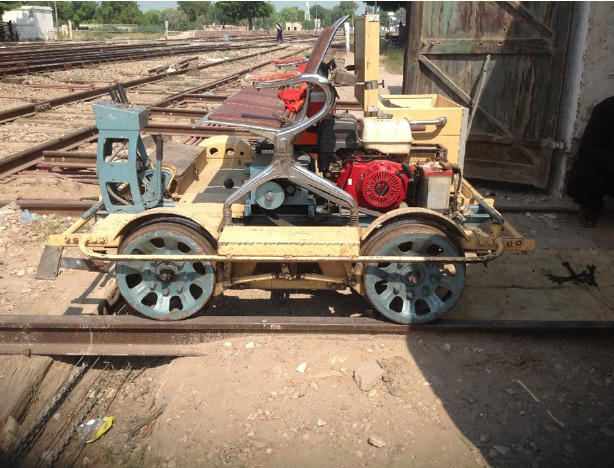
Figure 3. The railway cart equipped with microphones for the data collection [19].